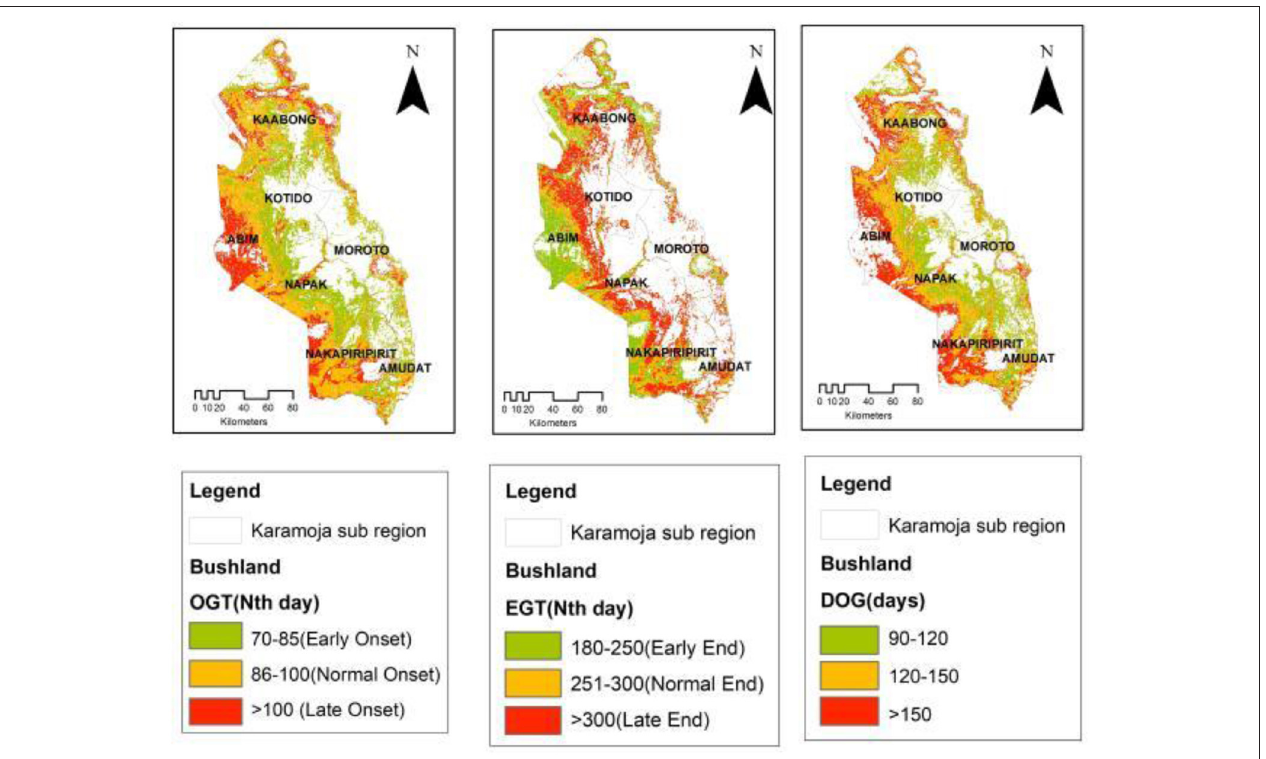
FIGURE 5 | Bushland OGT, EGT, and DOG spatial